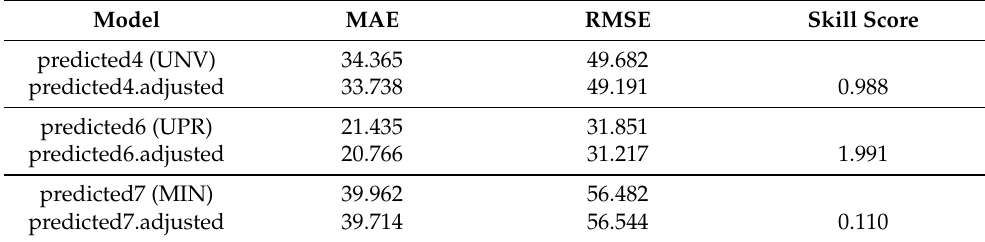
Table 7. Standardized based models evaluation.